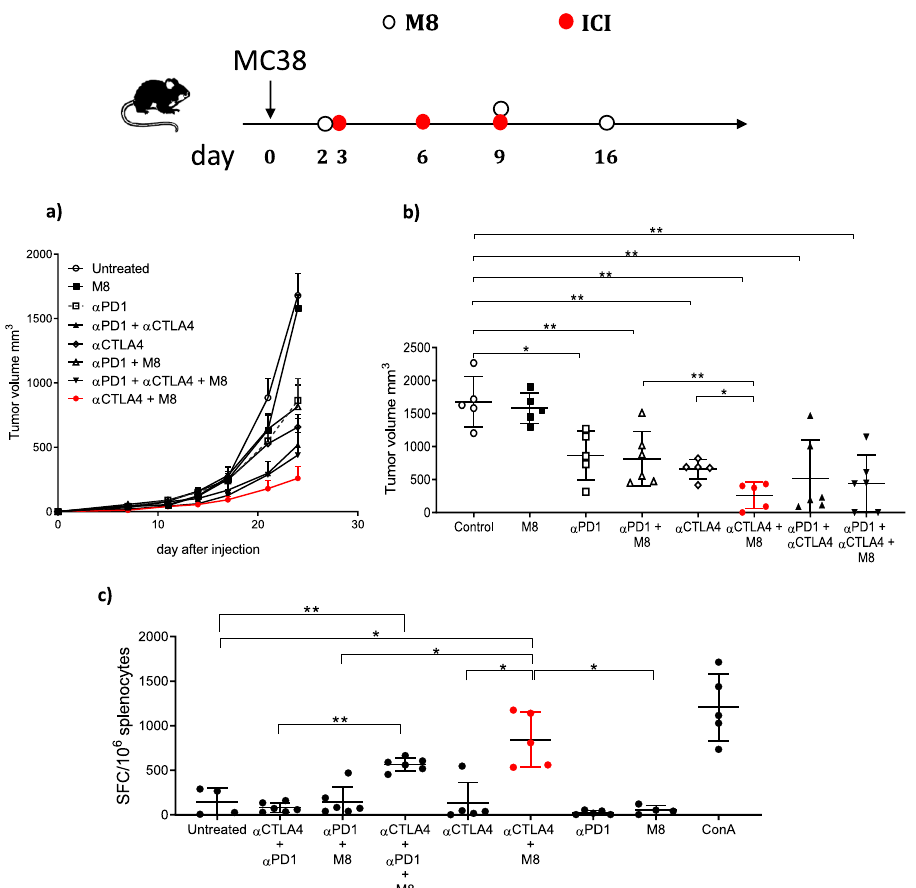
Fig. 2 Therapeutic effect of M8 in combination with ICI. C57Bl/6 mice were inoculated s.c. with MC38 cells and treated with M8 vaccine delivered by EP and ICI according to the experimental scheme. a Tumor volumes followed over time. b Final tumor volume measurements, single tumor volumes are depicted from one experiment out of two performed. Mann – Whitney tests were conducted * p < 0,05 ** p < 0.01 *** p < 0.001. c At day 27, mice were sacri fi ced and IFN γ producing cells were evaluated by IFN γ ELISpot assay with splenocytes restimulated with neoantigens pool or ConA as a positive control. Signi fi cance was determined using Mann – Whitney test, * p < 0,05 ** p < 0.01 *** p < 0.001. Six animals per group were utilized. Each symbol represents an individual sample with the error bars representing the s.e.m. Only the most relevant statistics were